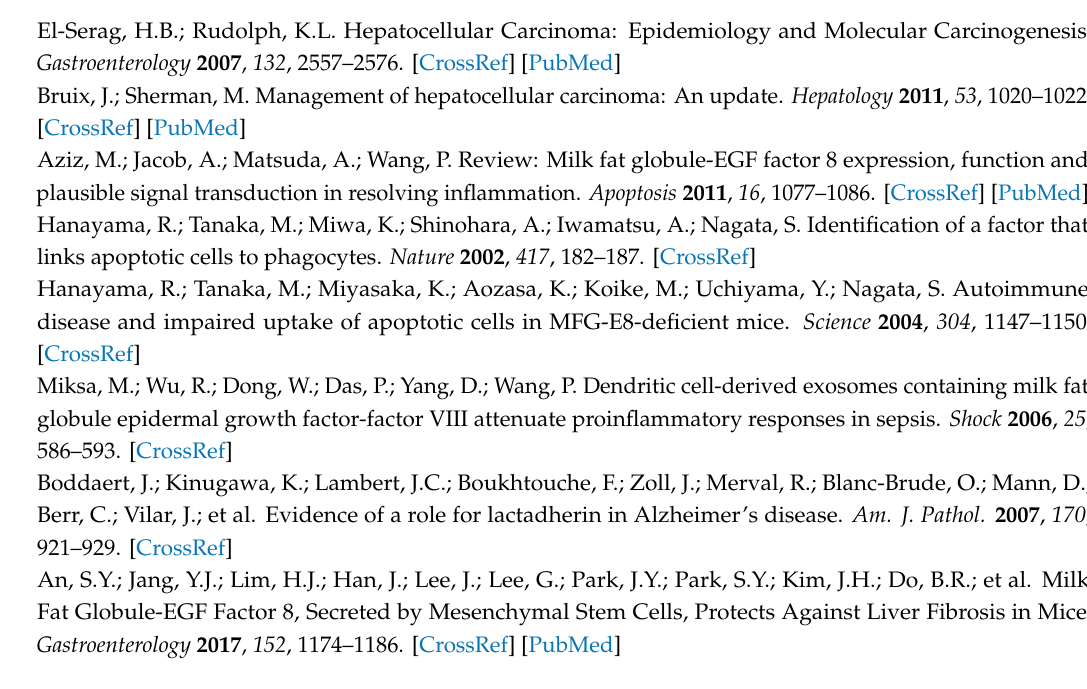
Figure S1: E ff ects of MFG-E8 overexpression on migration of HepG2 and Hep3B cells, Figure S2: E ff ects of MFG-E8 activity inhibition on HepG2 cell migration, Figure S3: E ff ects of MFG-E8 activity inhibition on Hep3B cell migration, Figure S4: E ff ects of MFG-E8 knockdown on HepG2 and Hep3B cell migrations, Figure S5: Growth of tumors in HCC xenograft animals after injections of MFG-E8 overexpressing Hep3B and HepG2